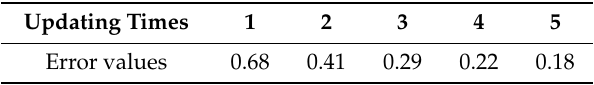
Table 3. Error values during lexicon